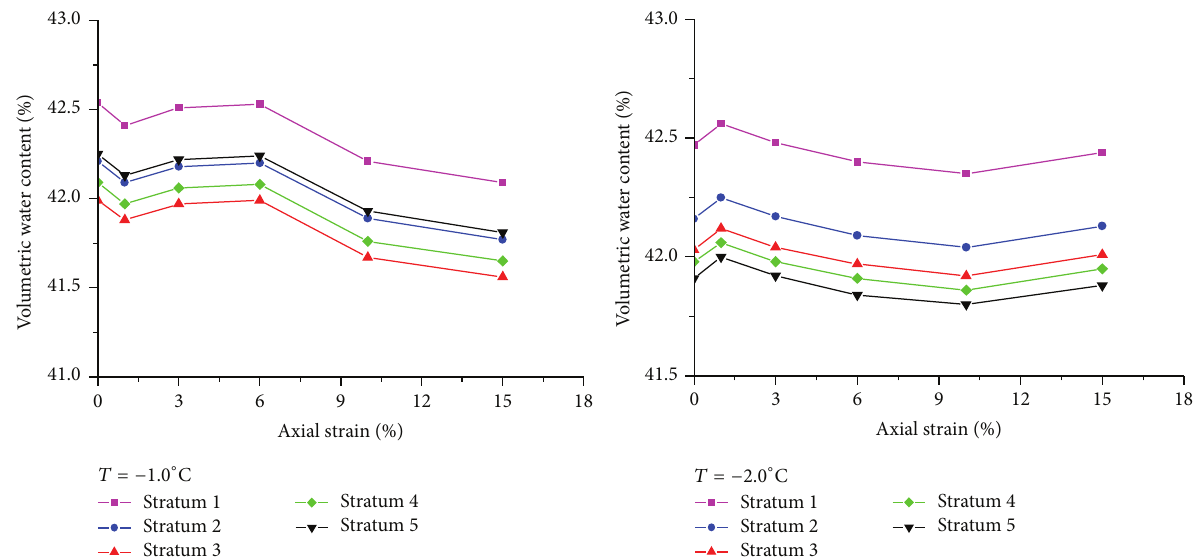
Figure 7: Distributions of volumetric water contents for warm and ice-rich frozen silt.